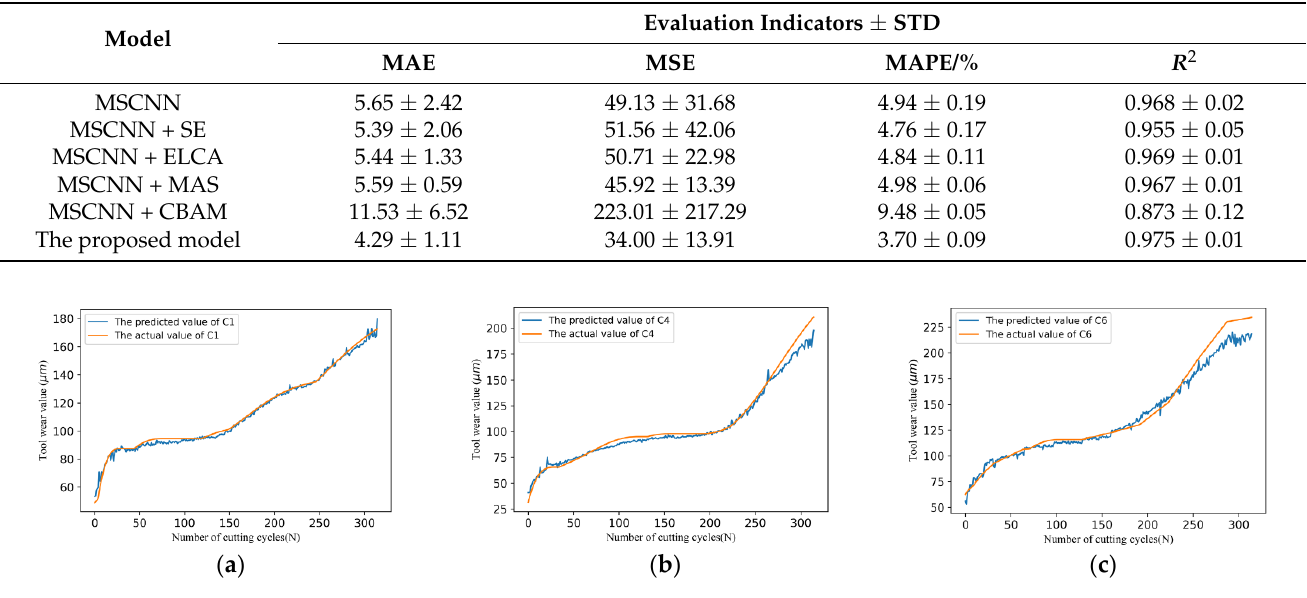
Figure 6. The prediction results of the model proposed in this paper on datasets. ( a ) C1, ( b ) C4, and ( c ) C6. 𝑃 𝑀𝐴𝐸 = 4.29 , 𝑃 𝑀𝑆𝐸 = 34.00 .